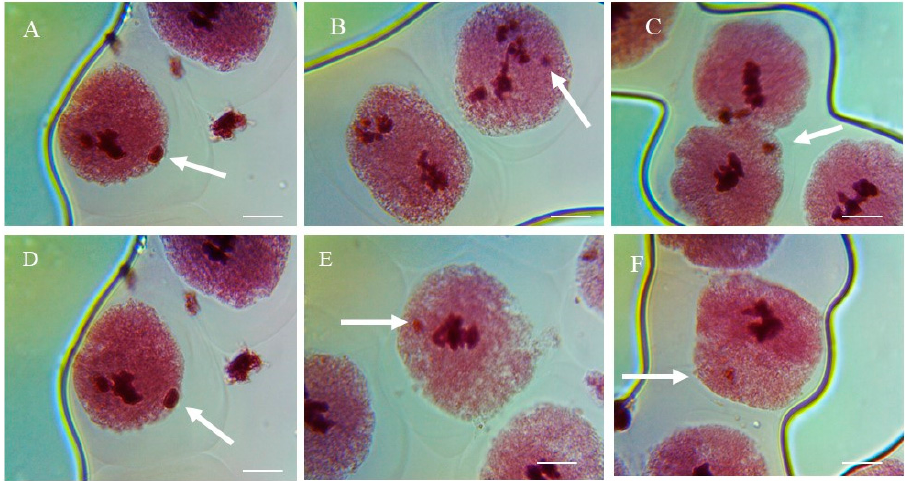
Figure 7. Representative images of micronucleated cells ( A – F ) in pollen-mother cells of P. sativum seeds treated with different concentrations of methomyl (ME) and imidacloprid (IM) for 1, 3, and 6 h. Arrows indicate micronuclei. Scale bars = 10 μ m